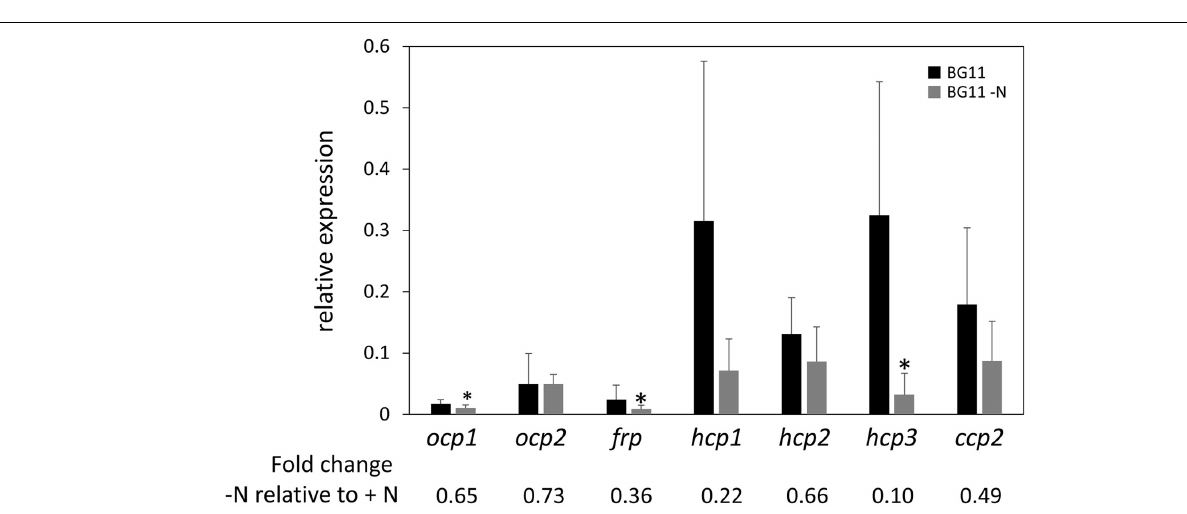
FIGURE 5 | Expression of ocp homologs in response to nitrogen limitation stress. The expression levels of ocp1 , ocp2 , frp , hcp1 , hcp2 , hcp3 , and ccp2 were measured using qPCR, comparing samples incubated for 24 h in BG-11/HEPES without nitrogen to control samples maintained in BG-11/HEPES with nitrogen ( ± SD, n = 6). ∗ p < 0.05 as determined by a two tailed Student’s t -test for the comparison of the treated and untreated